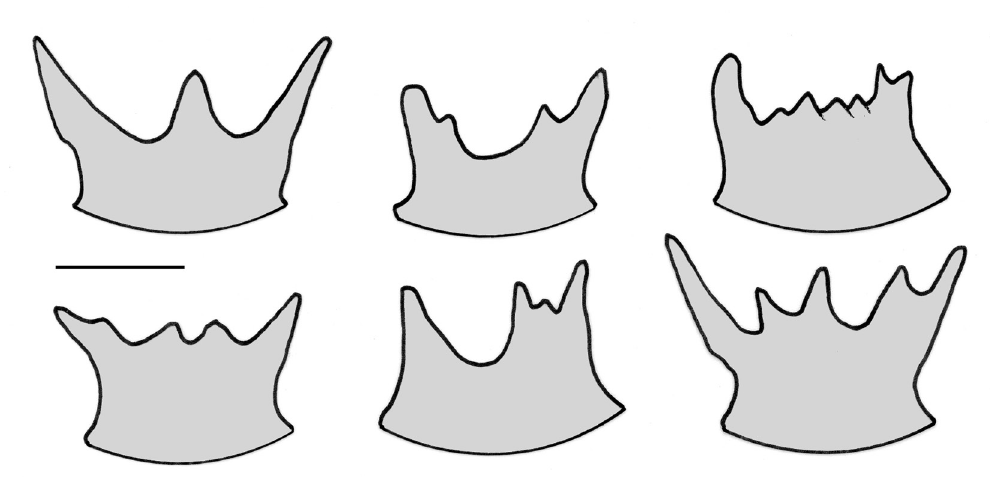
Fig. 8. Atlantisina lionensis gen. et sp. nov. Intraspecific variability in the morphology of the suboral crest. Scale bar: 200